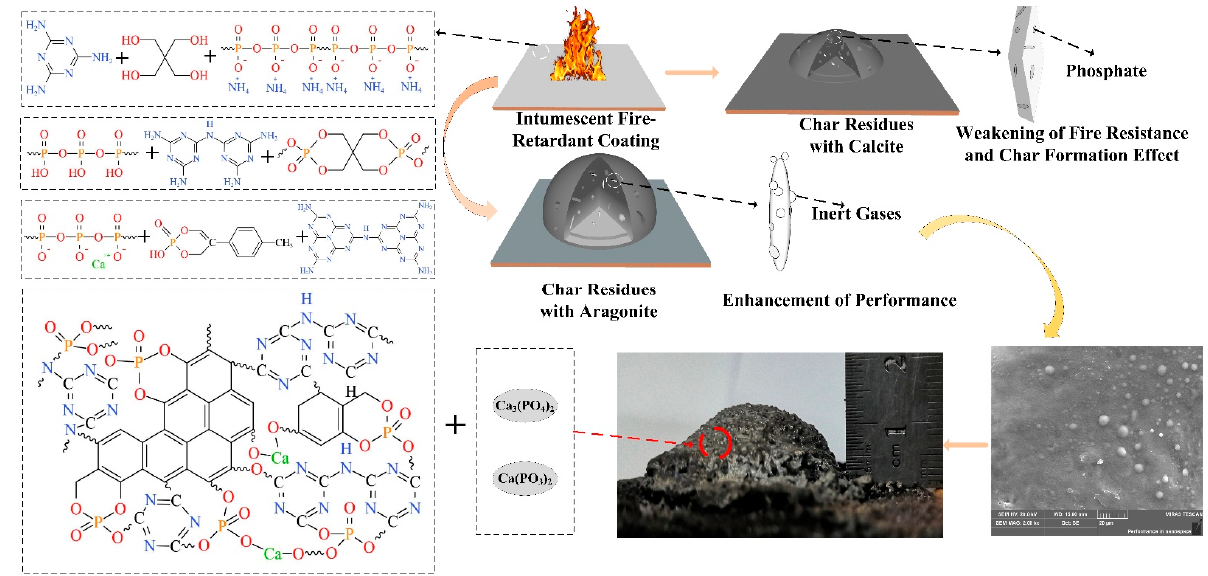
Figure 13. Fire resistance and char-forming mechanism of the different shell bio-fillers.